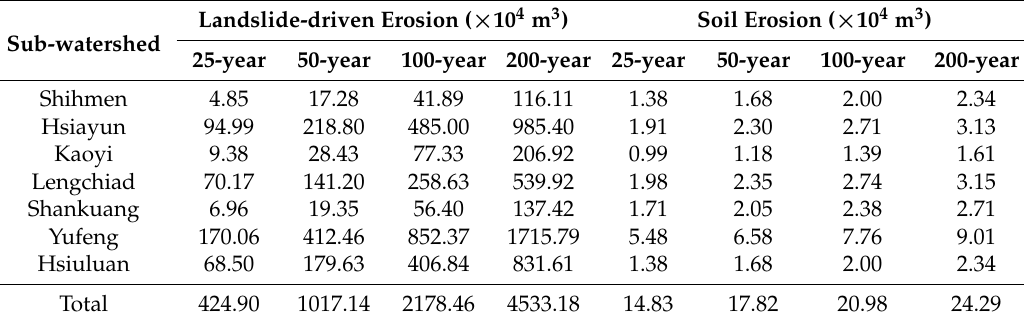
Table 5. Predicted sediment production under different rainfall return